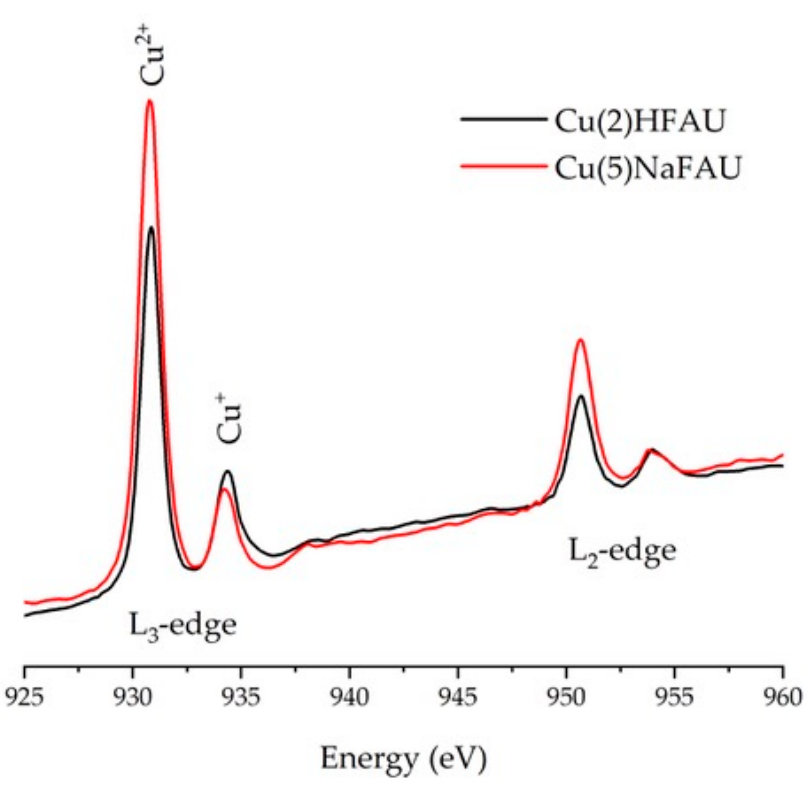
Figure 3. Partial fluorescence yield X-ray absorption spectroscopy (XAS) spectra of the Cu L-edge regions of Cu(2)HFAU and Cu(5)NaFAU zeolites.